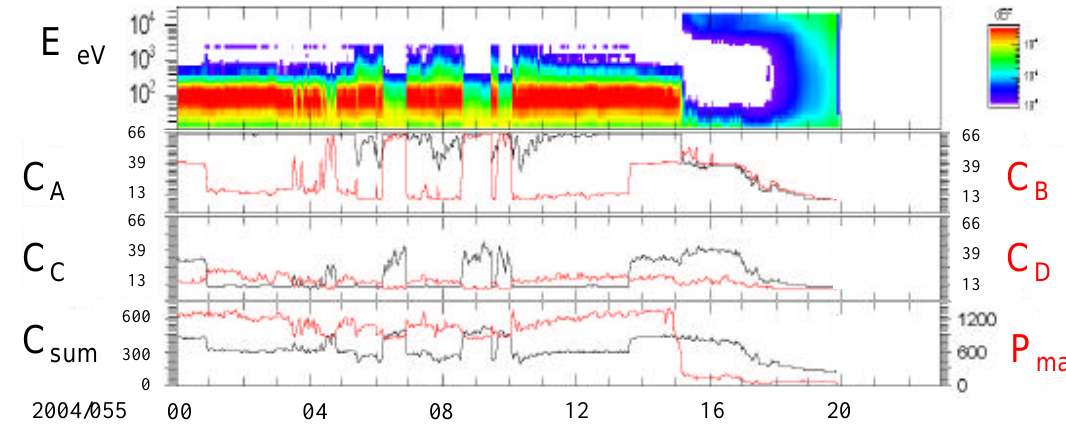
Fig. 12. Illustration of the variation with plasma environment of the number of transmitted JPEG coefficients per